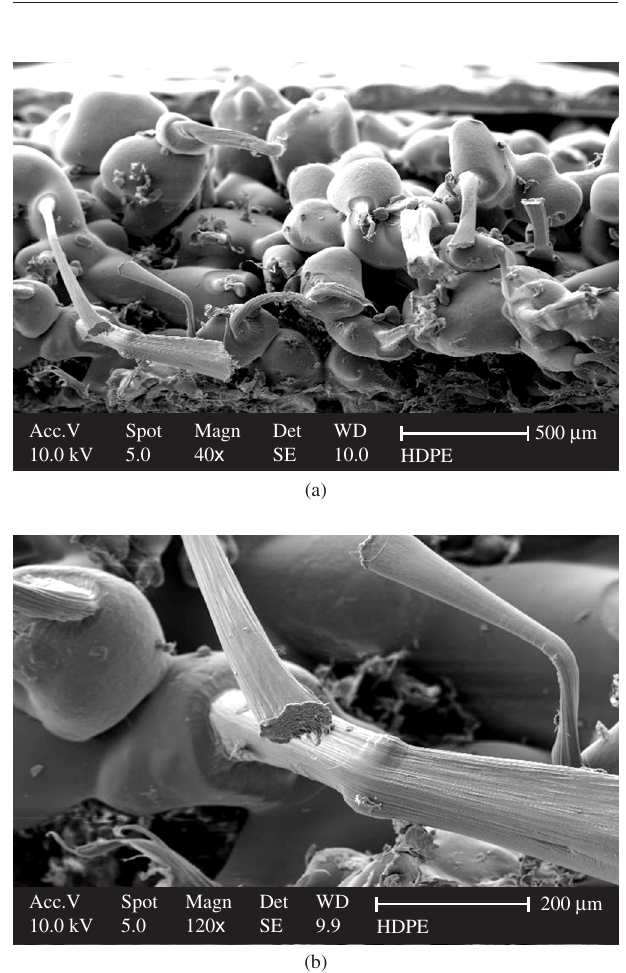
Figure 3. Fracture surface of the HDPE samples fabricated with particles of 212-380 µ